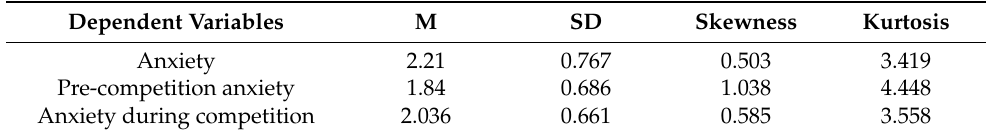
Table 2. The distribution of dependent variables.